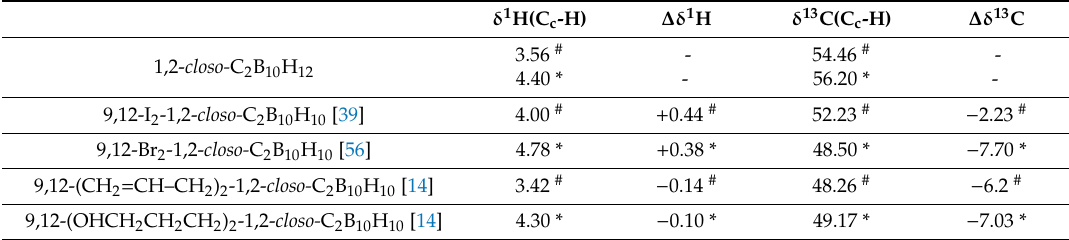
Table 5. 1 H- and 13 C{ 1 H} NMR chemical shift values (in ppm) of C c -H vertexes for several in *(CD 3 ) 2 CO or # CDCl 3